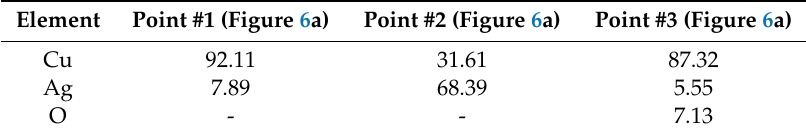
Figure 6. ( a ) Microstructure of Cu after alloying by Ag: #2 Cu + Ag eutectic; ( b ) analysis of energy dispersive x-ray spectroscopy (EDS) from the micro-area #1; ( c ) analysis of EDS from the micro-area #2;